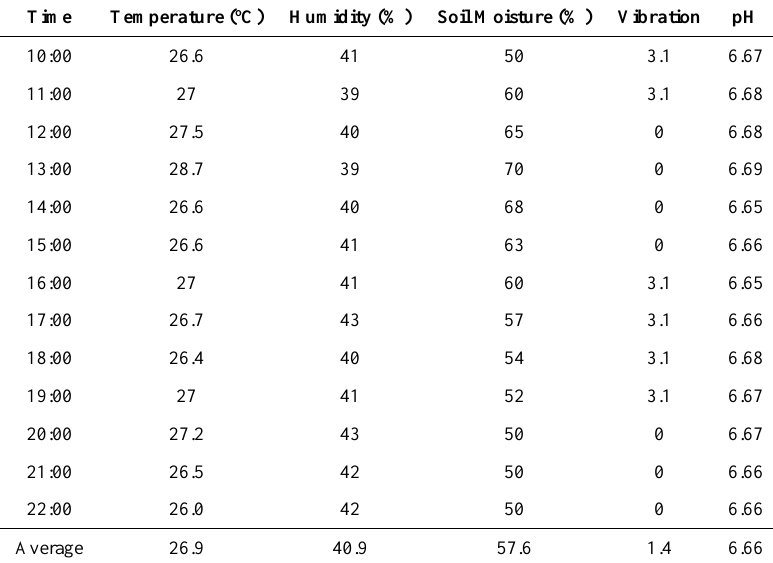
Table 1. Variation of parameters according to